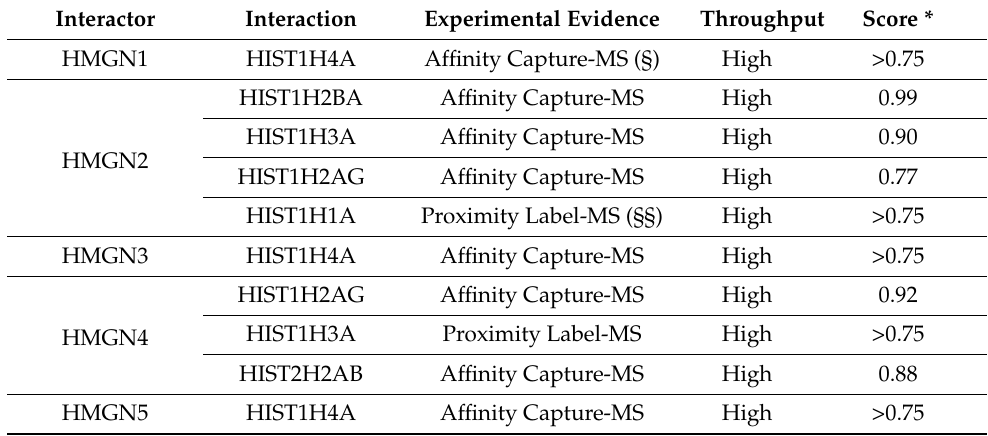
Table 4. BioGRID data of the five human HMGN interactions with the nucleosome core histones H2BA, H2AG, H2AB, H3A, and H4A and with the linker histone H1A.